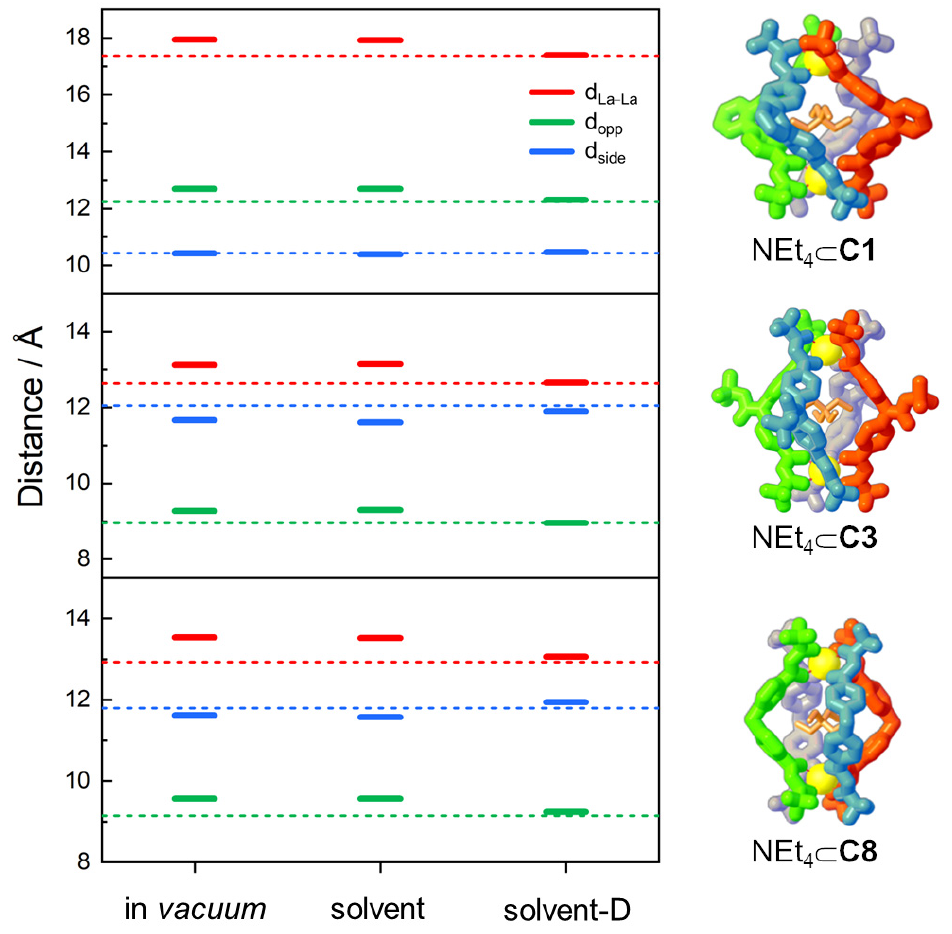
Figure 5. The solid bars represent the calculated values for the different distances along the axial direction (d La–La , blue) and on the equatorial plane (d opp , red, and d side , green), for the most stable structures. The dashed lines indicate the SCXRD data values. Distances are in Å.